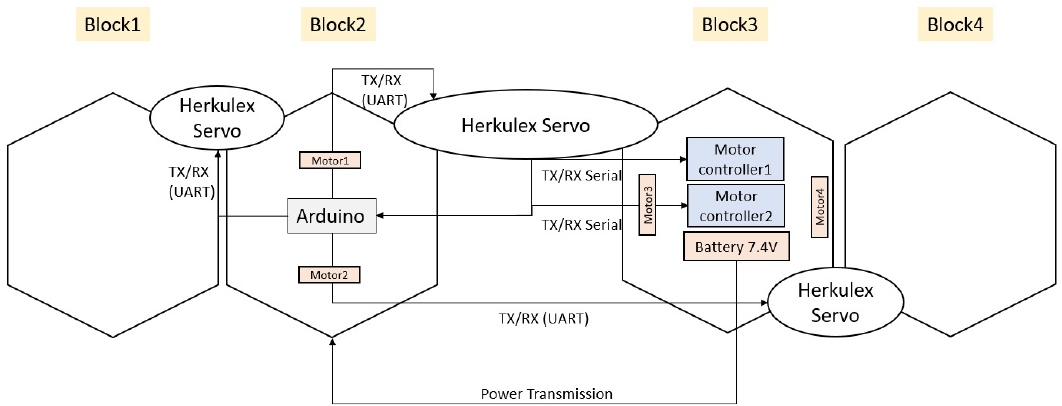
Figure 3. Block diagram of the electronics module of